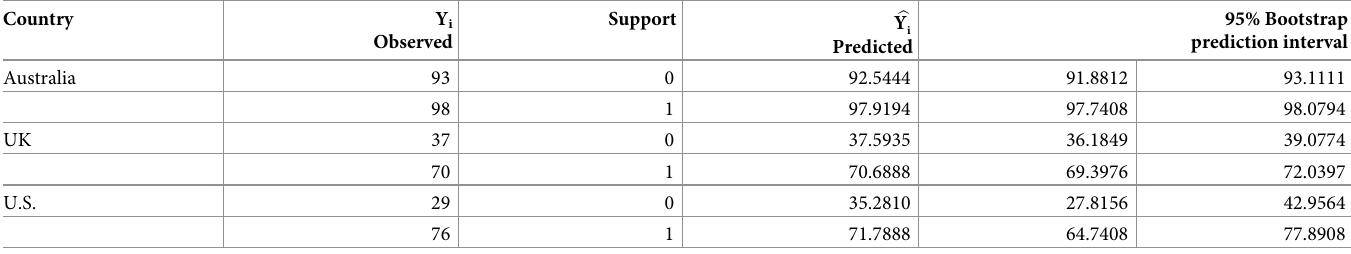
Table 4. Predictions based on the wild bootstrap methods.